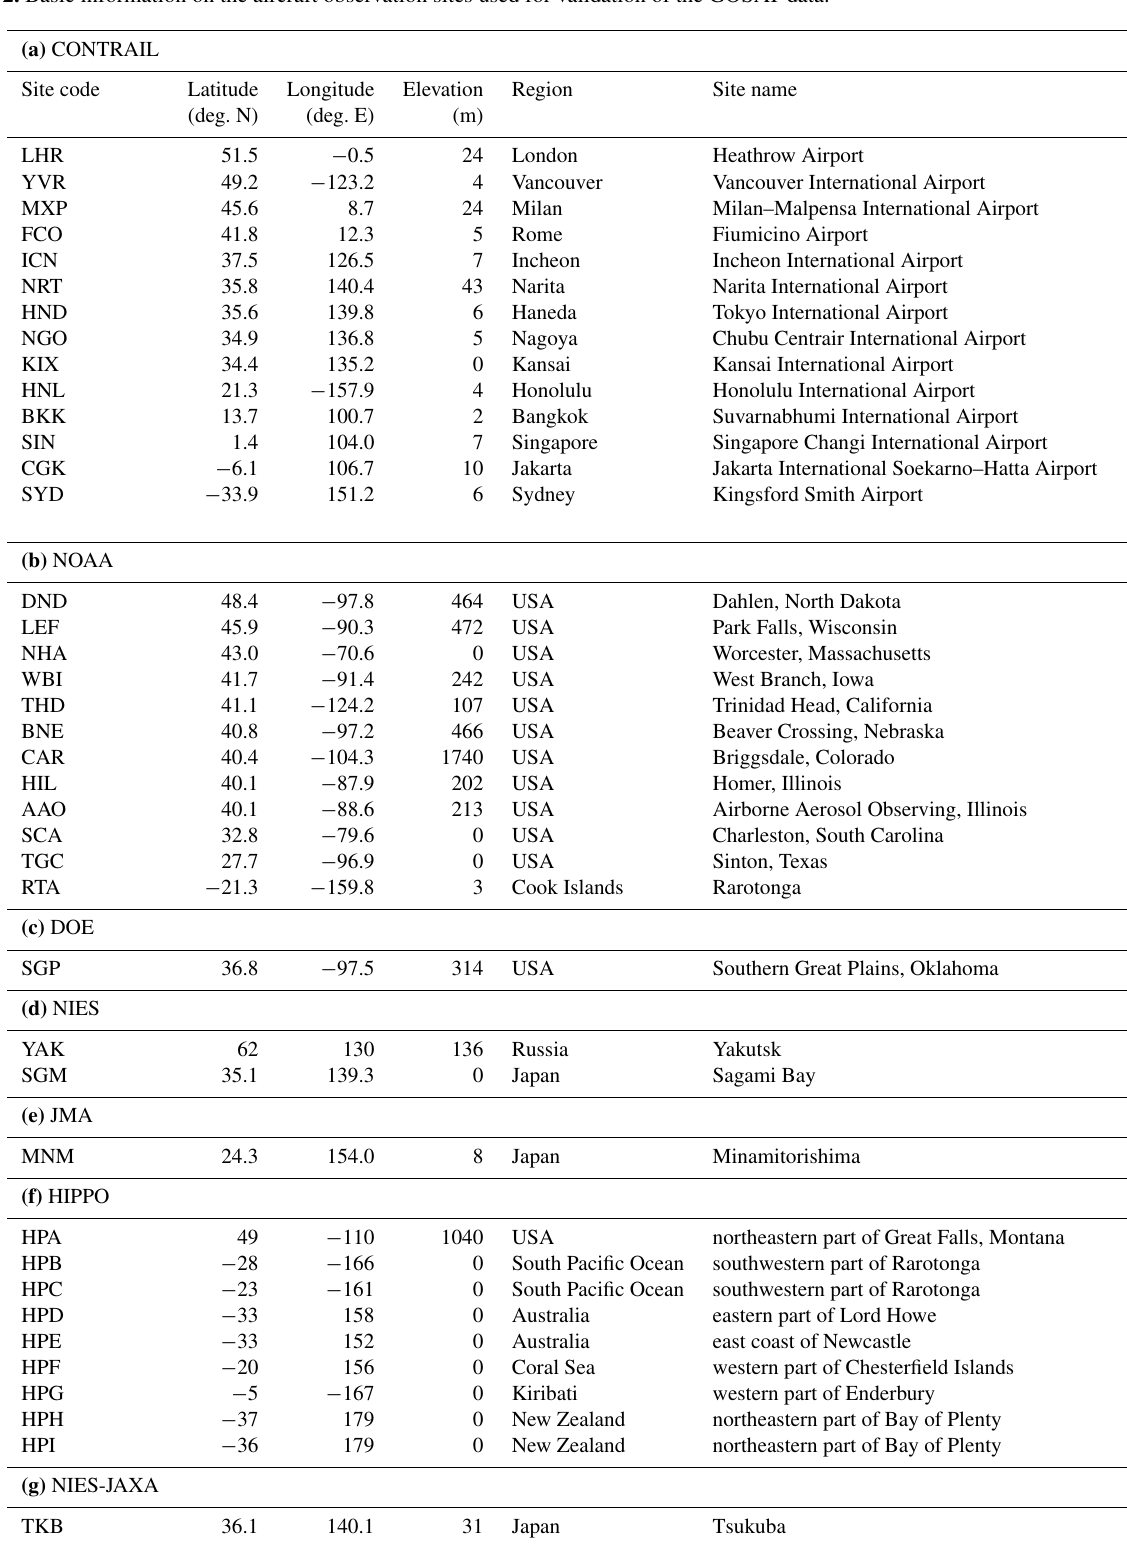
Table 2. Basic information on the aircraft observation sites used for validation of the GOSAT data. (a)